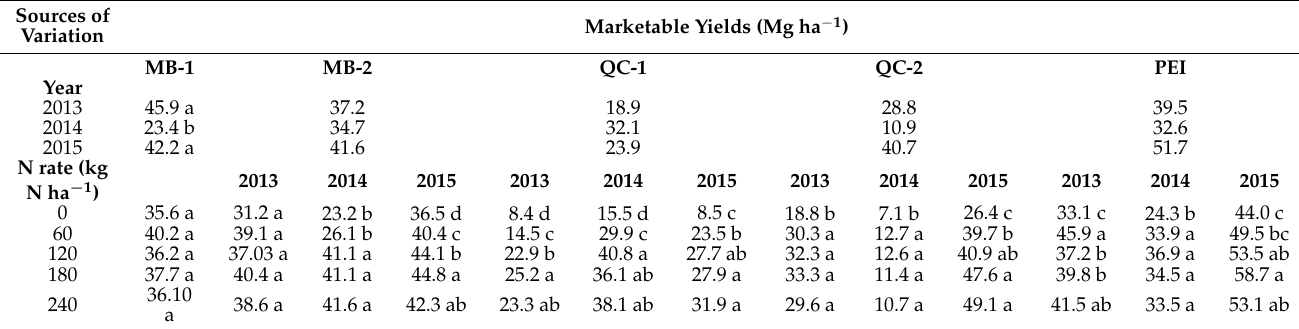
Table 7. Marketable potato responses to N rate at different sites.